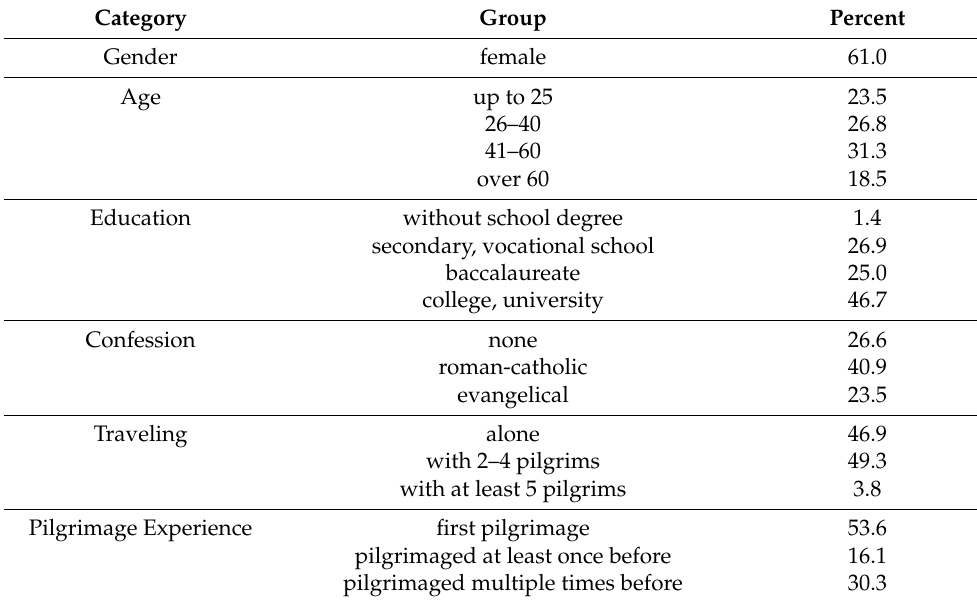
Table 2. Demographics of the Sample of German-Speaking Pilgrims ( N = 425).